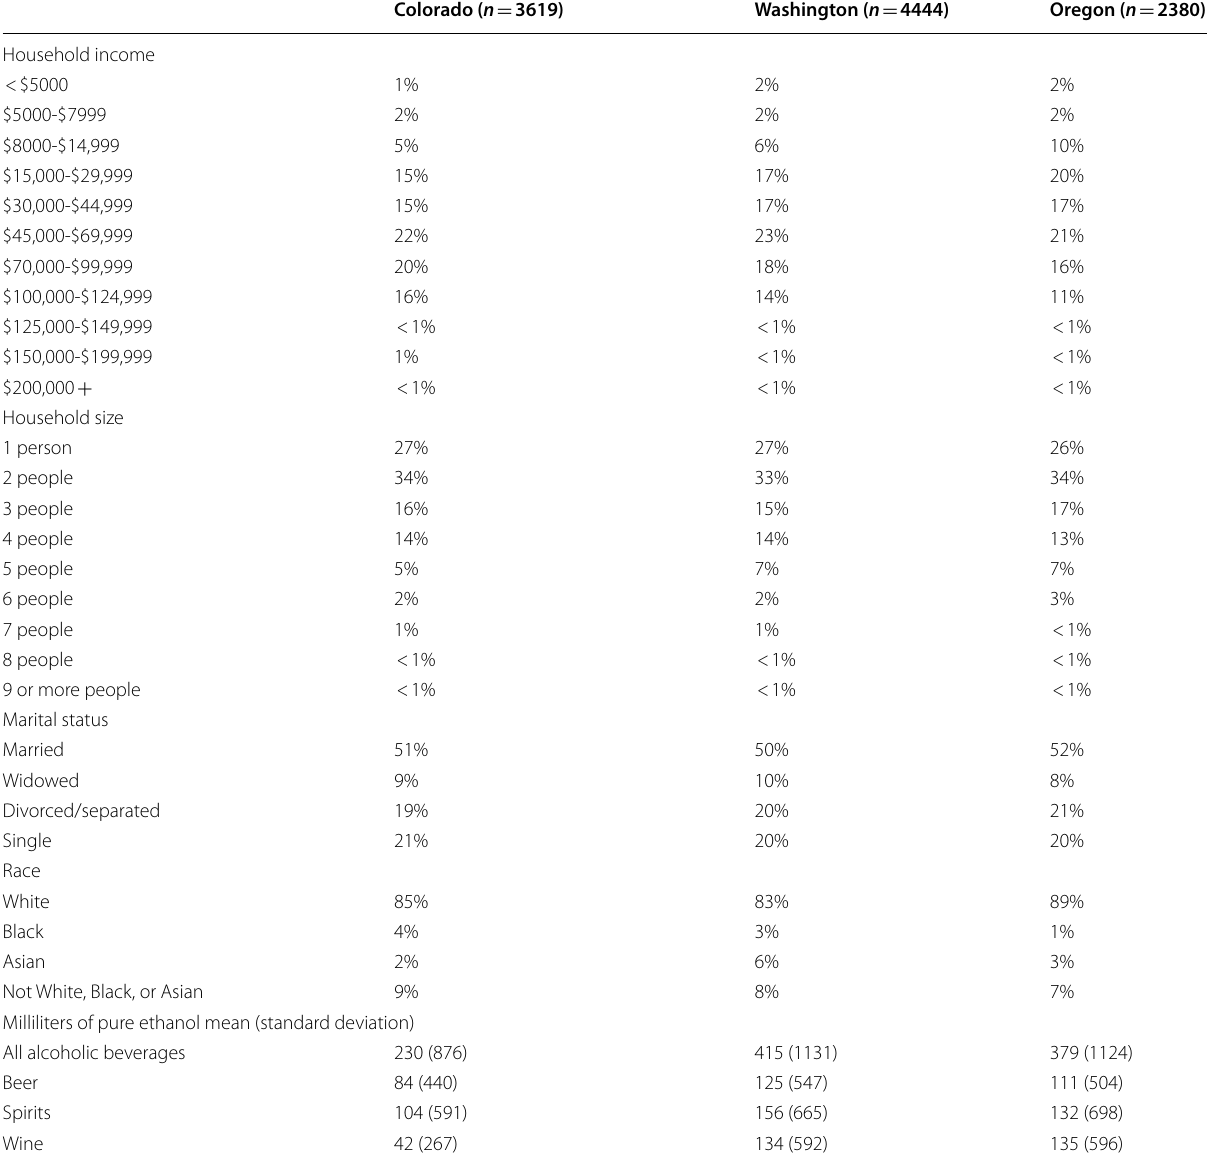
Statistics presented in the above table are from the unrestricted sample of households (i.e., not limited to households with data before and after legalization) using Nielsen frequency weights. Data are from 2004 to 2017. Household income is the self-reported income of a household upon entry into the NCP. Household size is the number of people living in a household. Race refers to the self-reported racial identity of the household. Milliliters of pure ethanol is the average milliliters of ethanol purchased by a given household in a given